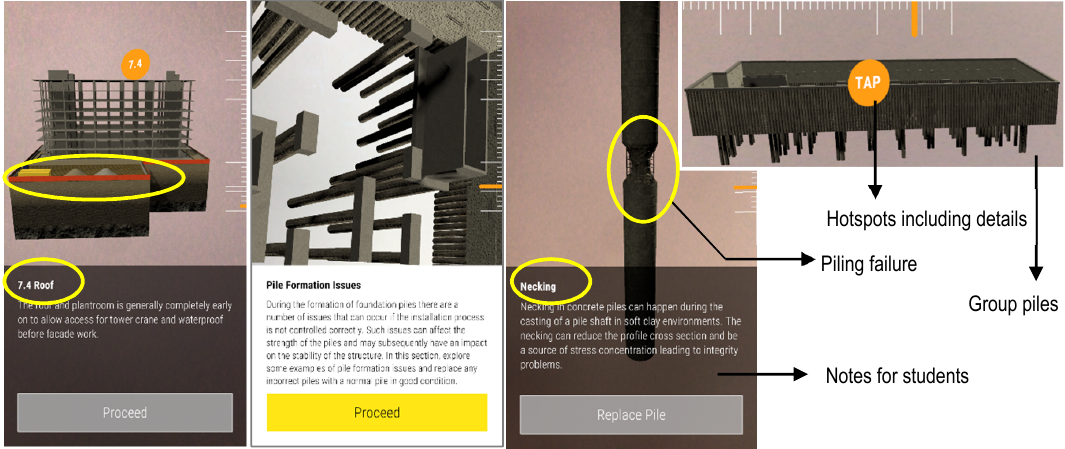
Figure 13. VR hardware for the collaborative model experience—the Oculus Quest. Appl. Sci. 2020, 10, x